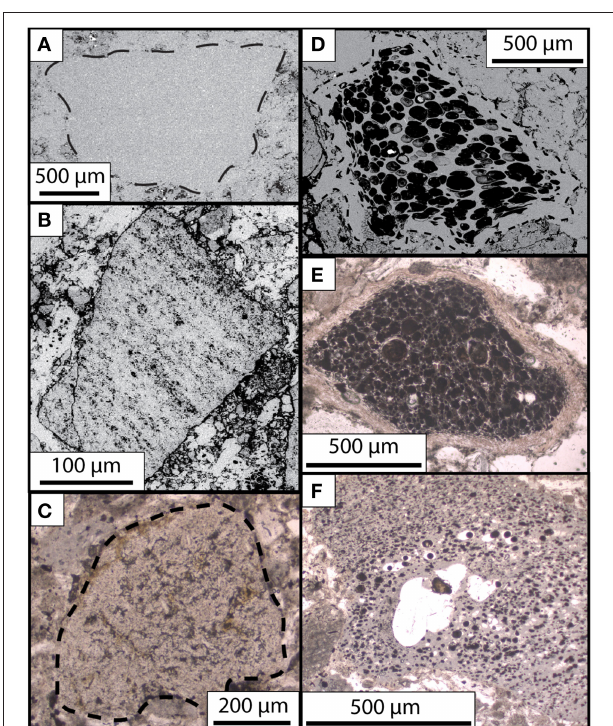
FIGURE 3 | Typical examples of different clast types displayed as optical photomicrographs (in reflected light—A,B,D, and transmitted light—C,E,F). (A) Dense clast with angular form; (B) angular banded clast; (C) sub-rounded crystalline lithic clast; (D) pale vesicular clast with prominent dense margin; (E) dark vesicular clast with prominent dense margin; (F) borderless vesicular